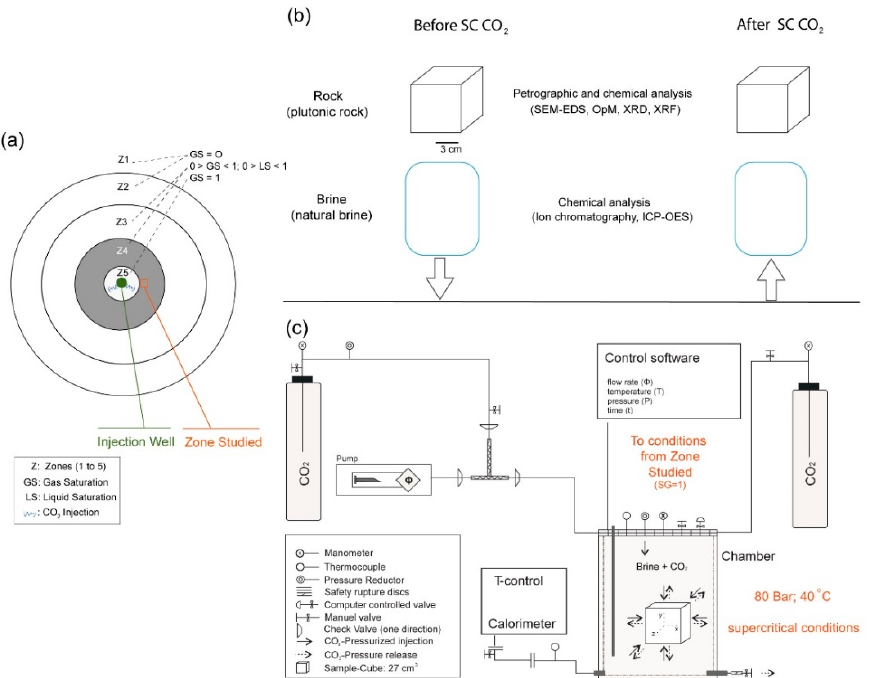
Figure 2. ( a ) Conceptual diagram of the reactive zones (Z1, Z2, Z3, Z4 and Z5) around the injection well according to [34] and [35] . ( b ) Sample preparation for mineralogical and geochemical analyses before and after SC CO 2 exposition. ( c ) Layout of the experimental setup. Reactor system used for the pressurized CO 2 injection (modified from. [36]).